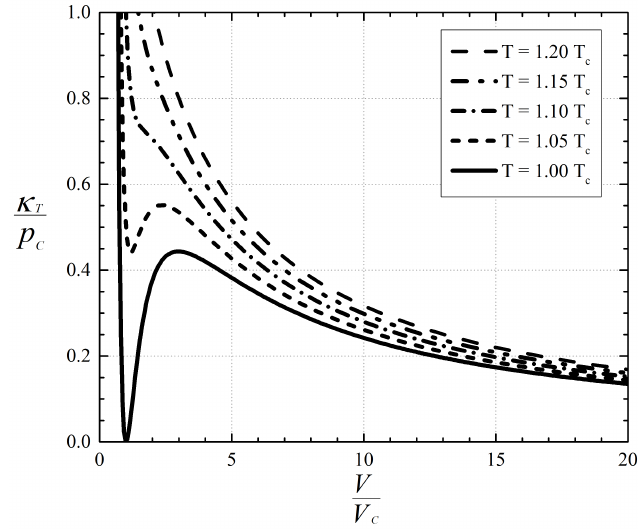
Figure 1. Variation of the scaled bulk modulus with reduced specific volume for CO 2 . Subscripts “ c ” will always denote quantities evaluated at the thermodynamic critical point and V ≡ ρ − 1 = the specific volume. The curves were generated using the Redlich–Kwong–Soave (RKS) equation of state. Details of the RKS equation are given in [25] along with the physical constants for CO 2